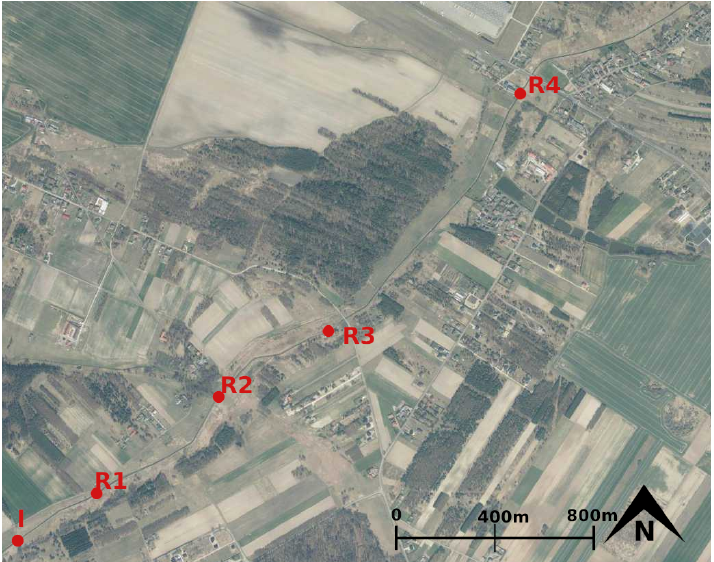
Figure 1. Aerial picture of the study site taken before the construction of the beaver dam. Dots mark injection point I and sampling points R1–R4. Modified from https://mapy.geoportal.gov.pl/ (accessed on 15 April